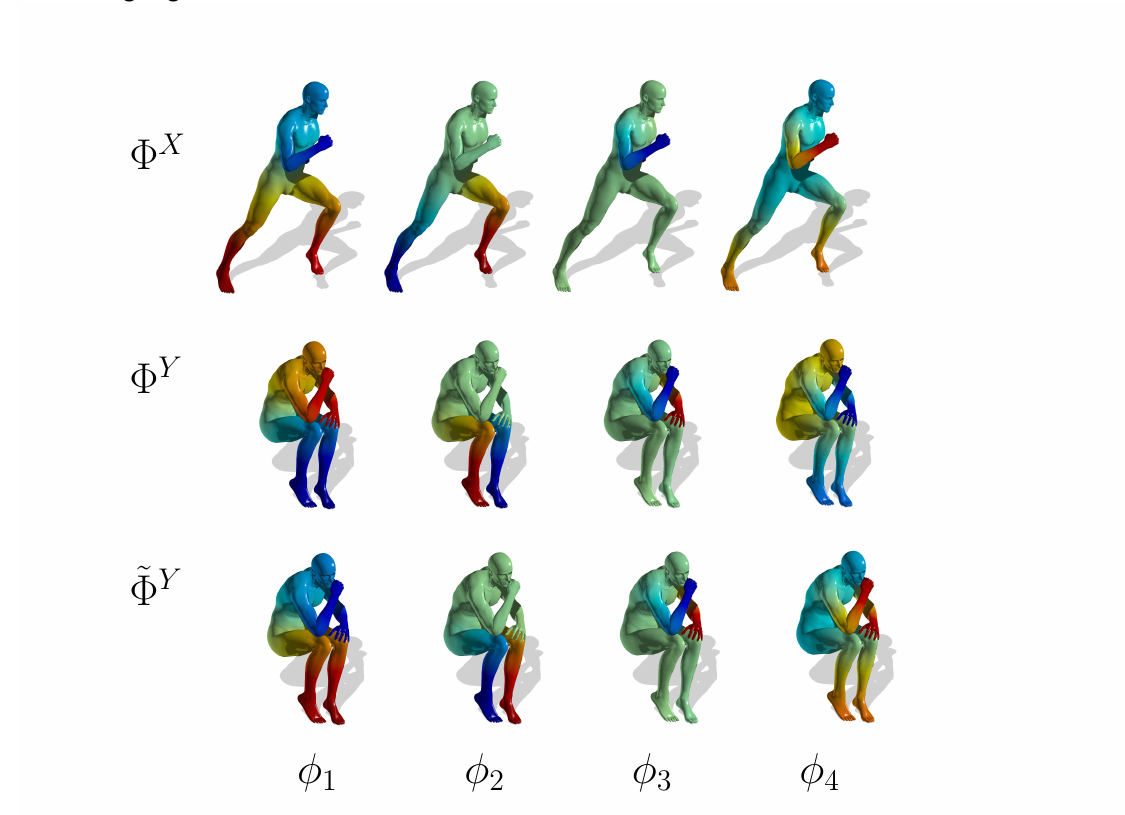
Figure 3. Eigenfunction matching of two nearly isometric shapes. Hot and cold colors represent positive and negative values, respectively. ( Top ) The first pose of a human; ( center ) the second pose of a human; ( bottom ) the second pose of a human after the matching algorithm.